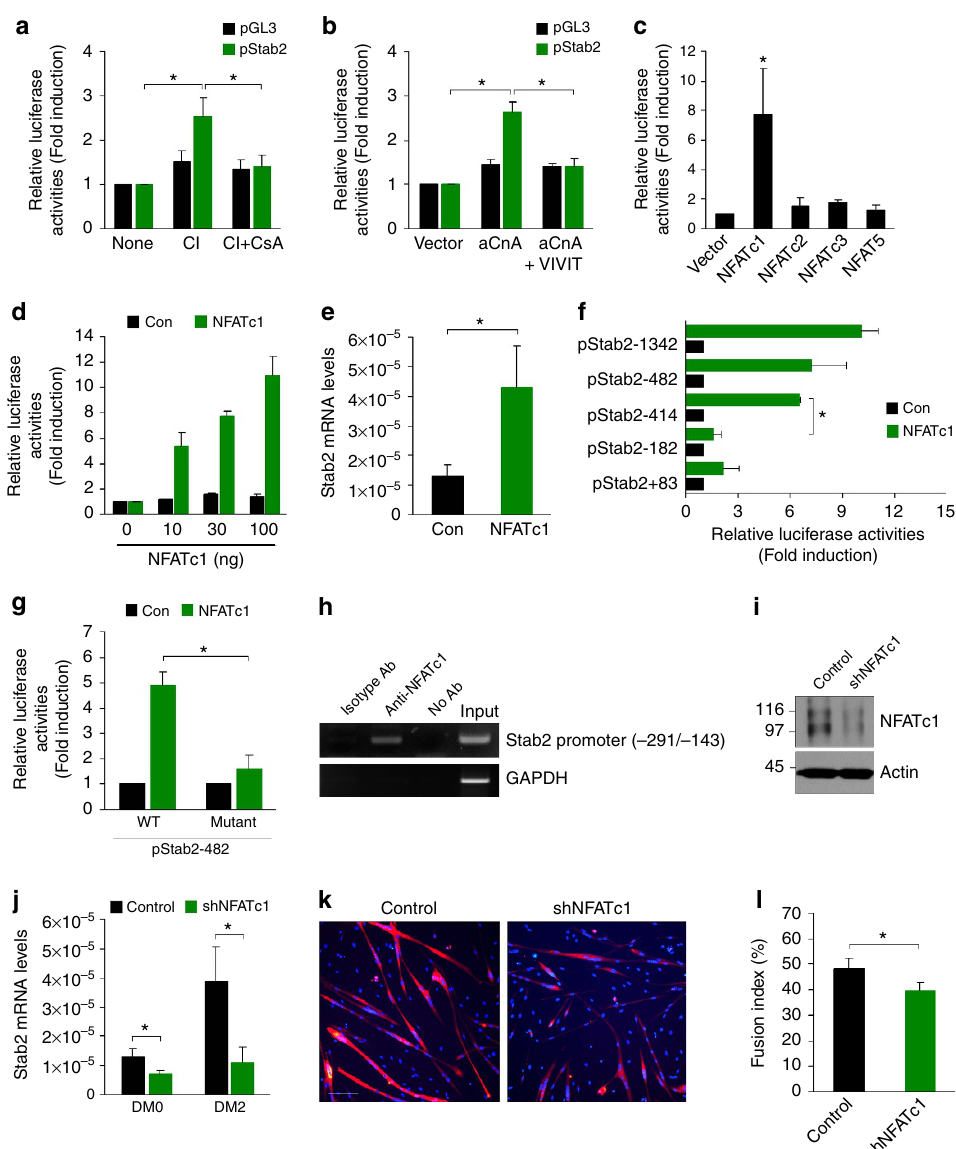
Figure 2 | Stabilin-2 expression is regulated by calcineurin/NFAT signalling. ( a ) Luciferase assay in primary myoblasts transfected with the stabilin-2 promoter construct. At 24h post-transfection, cells were incubated with vehicle, calcium ionophore A23187 (CI, 1 m M), or CI plus cyclosporine A (CsA, 1 m M) for 24h. ( b ) Luciferase assay in primary myoblasts transfected with the stabilin-2 promoter construct along with plasmid encoding activated calcineurin (aCnA) and/or GFP-VIVIT. ( c ) Luciferase assay in primary myoblasts transfected with stabilin-2 promoter construct along with the indicated NFATexpression vector. ( d ) Luciferase assay in primary myoblasts transfected with the stabilin-2 promoter construct along with the indicated amount of plasmid encoding NFATc1. ( e ) Real-time PCR analysis of Stab2 mRNA in primary myoblasts infected with retrovirus encoding NFATc1 or retrovirus from pMXs IRES-puro vector. ( f ) Luciferase assay in primary myoblasts transfected the stabilin-2 promoter construct or a series of 5’ deletion constructs along wth plasmid encoding NFATc1 or empty vector (Con). ( g ) Luciferase assay in primary myoblasts transfected with the stabilin-2 promoter